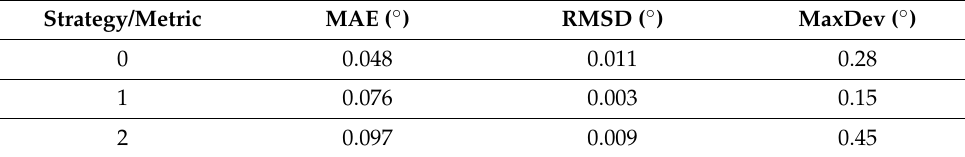
Table 1. Summary of the deviations in strategies positioning.